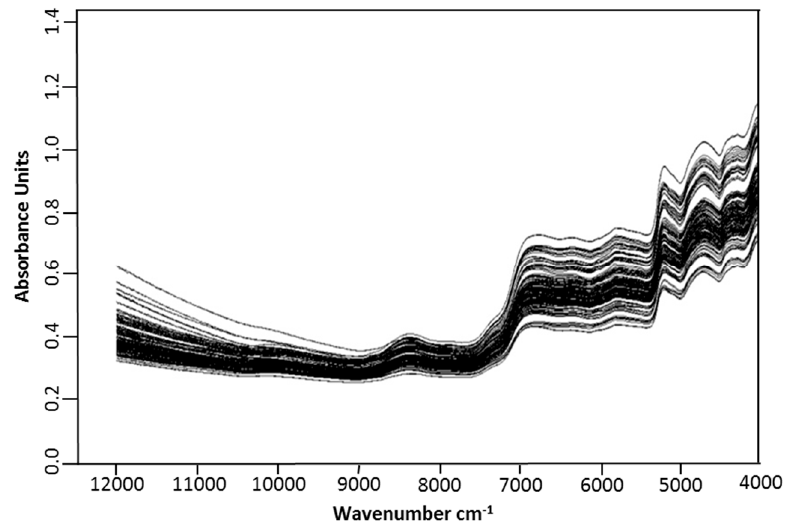
Figure 1. Raw Fourier transform near infrared (FT-NIR) spectra of researched samples.